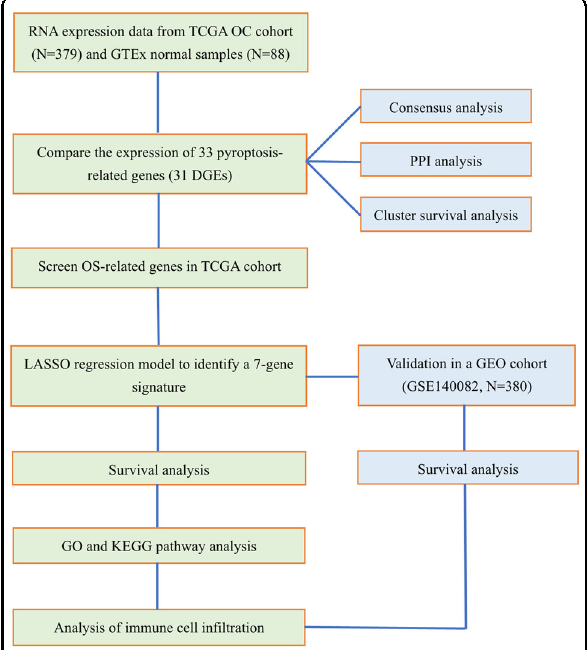
Fig. 8 Work fl ow diagram. The speci fi c work fl ow graph of data Statistical analysis Single-factor analysis of variance was applied to com- pare the gene expression levels between the normal ovarian and OC tissues, while the Pearson chi ‐ square test was used to compare the categorical variables. To com- pare the OS of patients between subgroups, we employed the Kaplan – Meier method with a two-sided log-rank test. To assess the independent prognostic value of the risk model, we used univariate and multivariate Cox regres- sion models. When comparing the immune cell in fi ltra- tion and immune pathway activation between the two groups, the Mann – Whitney test was used. All statistical analyses were accomplished with R software (v4.0.2). The overall fl ow diagram is shown in Fig. 8.